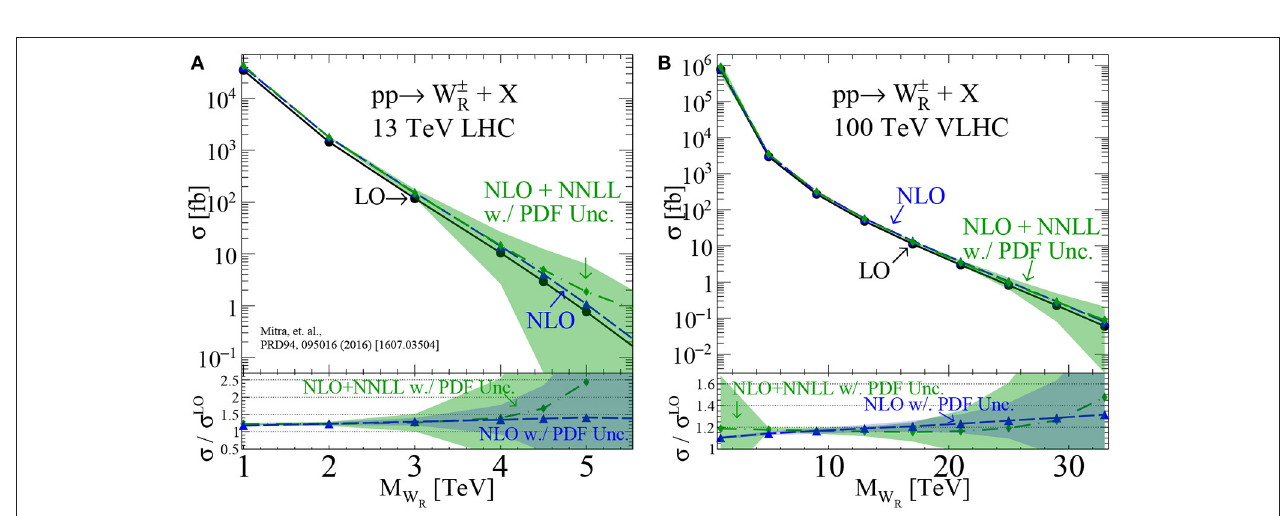
W R production cross section for √ s , pp R →